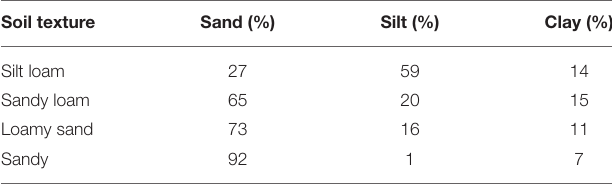
TABLE 1 | Particle size distribution of the four soil types used in the experiment. Soil texture Sand (%) Silt (%) Clay